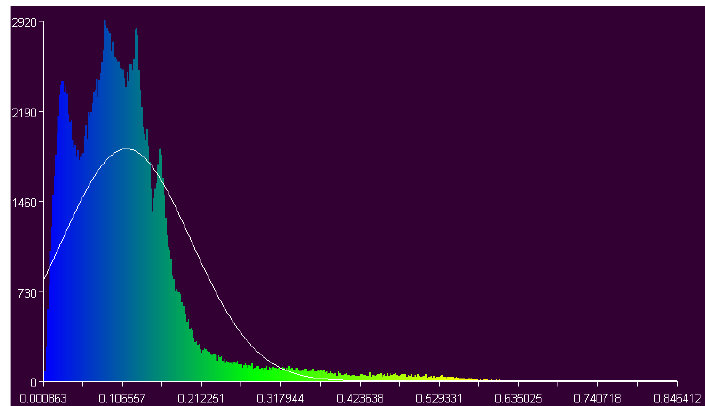
Figure 11: Distribution of the distances (in meter) between the example iPhone point cloud and TLS point